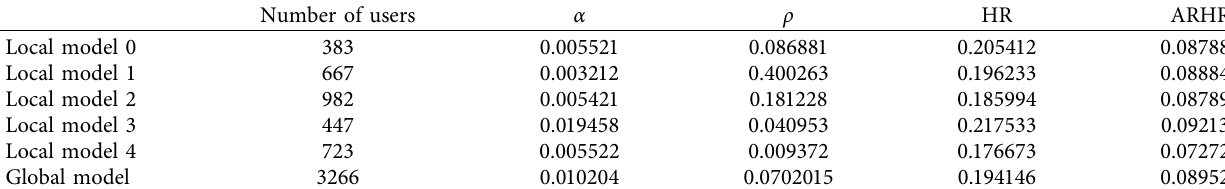
Table 6: Training results of the local model and global model.